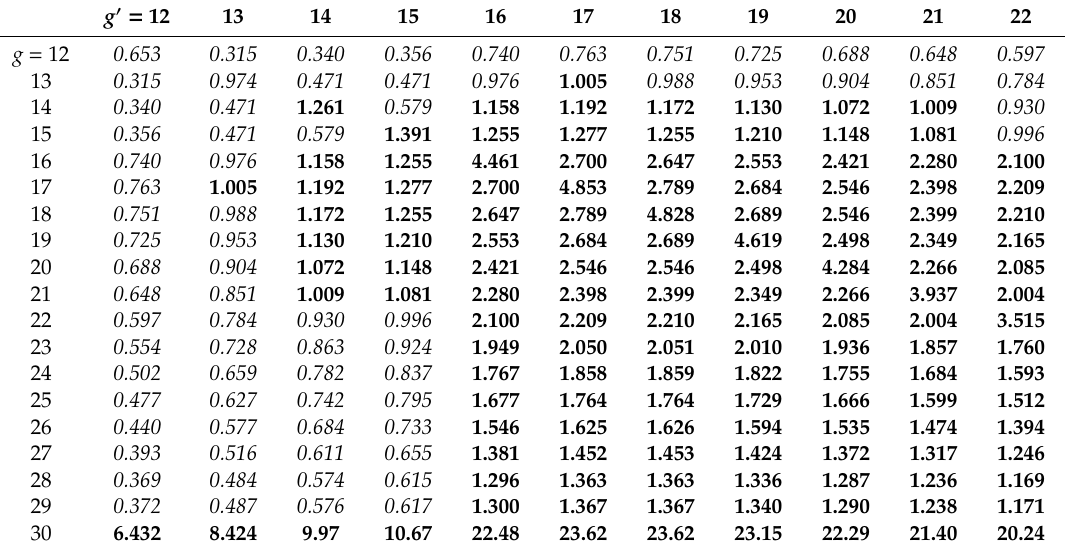
(cid:16) (cid:17) (cid:48) σ g , σ g , g , g (cid:48) = 1, ... ,30, having values greater than 1.0. t , i = 6 t , k = 6